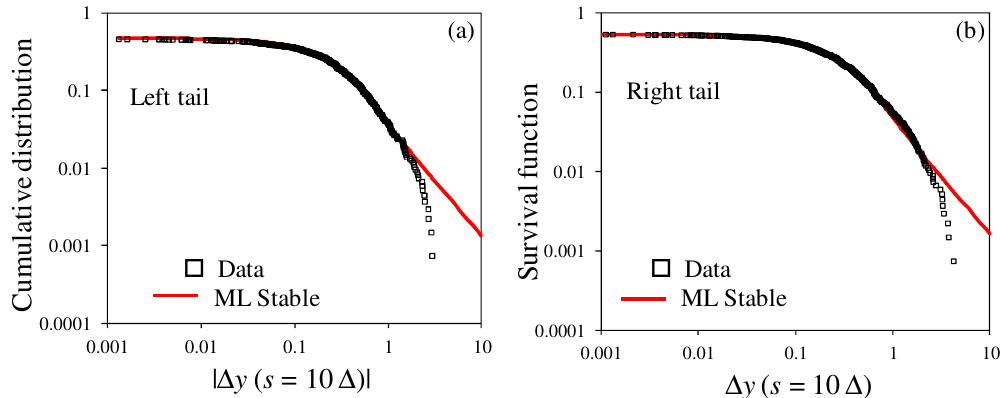
Fig. 13. (a) Empirical cumulative distribution and (b) survival function of increments 1y along x direction parallel to stratification computed on Berea sandstone faces at lag s = 10 1 compared with ML fits of stable